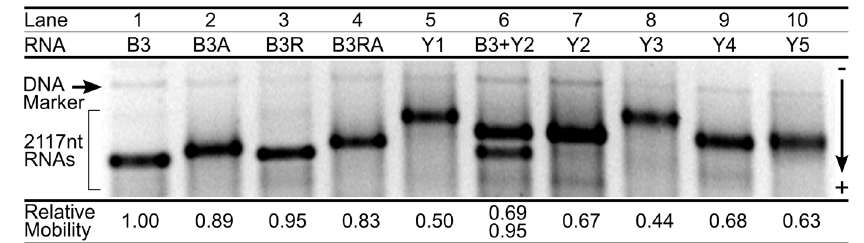
Figure 1. Gel electrophoretic mobilities of 2117-nt RNAs. Lanes 1–4 show a viral RNA (B3) and sequences engineered from it, while lanes 5 & 7–10 show yeast-based transcripts. Each lane contains < 1 m g of RNA, i.e., an ensemble of * 10 11 molecules. B3 & Y2 were mixed prior to running in